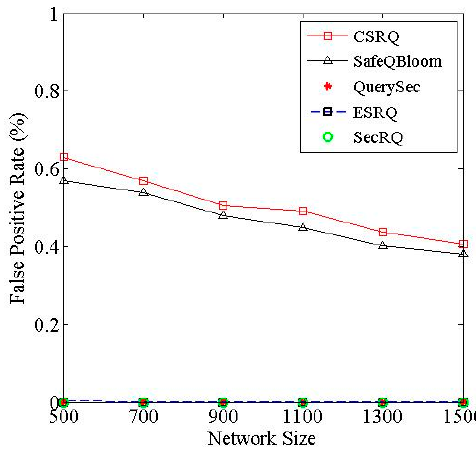
Figure 8. Impact of network size on false positive rate.